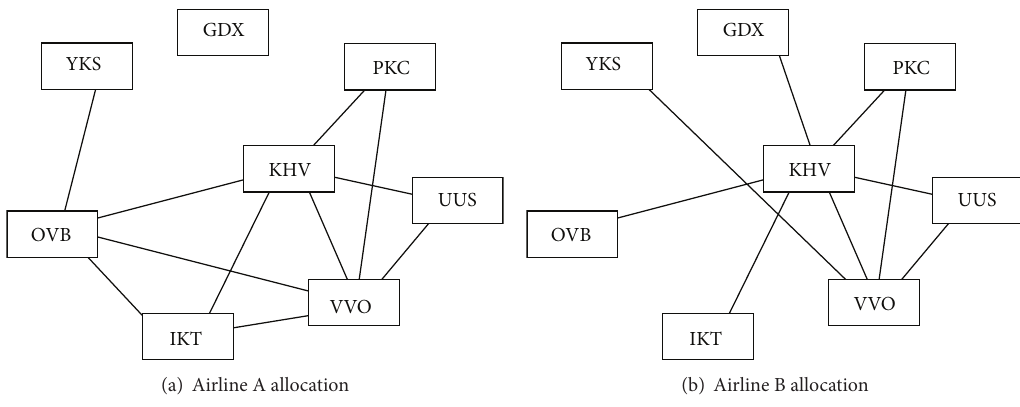
Figure 9: Equilibrium in location game (Russia).